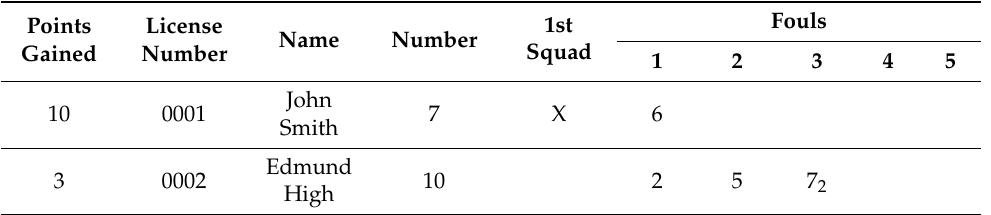
Table A1. Player details in match protocol.